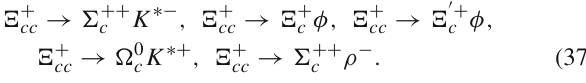
pressed processes, respectively. The errors are estimated by varying η from 1 to 2, and the central values are given at η = 1 . 5